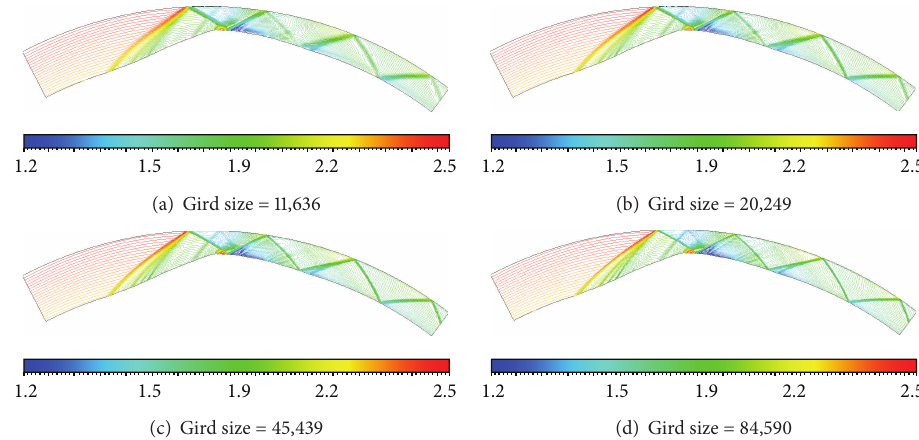
Figure 5: Comparison of Mach number contour of Rampressor inlet in different grid sizes.